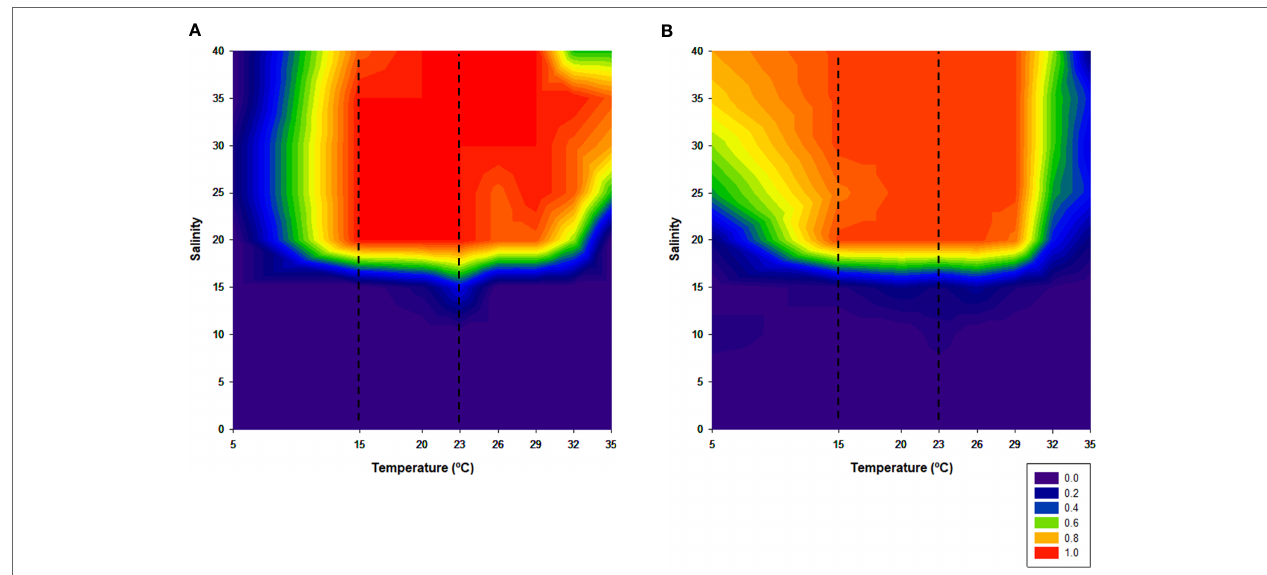
FIGURE 4 | Feeding behavior of juveniles (A) and adults (B) . Dotted lines represent the established control temperature range